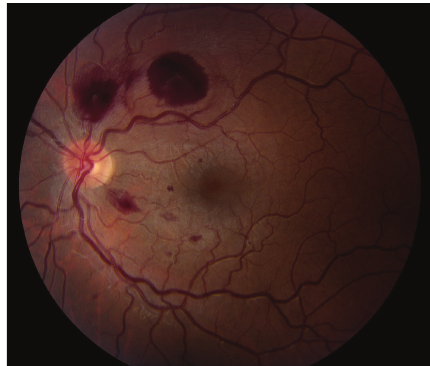
Figure 4: Color fundus photo of the right eye 3 months after presentation. Retinal hemorrhage has almost completely